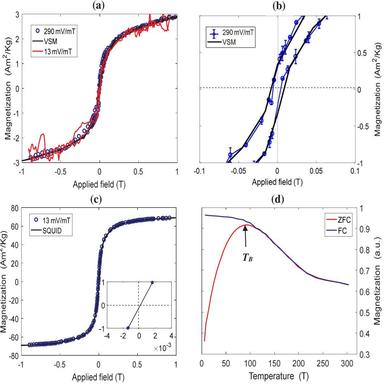
(a) Comparison of magnetization curves of the CoFe2O4 nanoparticles measured with our magnetometer in the 290 mV/mT (circles) configuration, measured with the VSM magnetometer (solid curve in black color) and measured with our magnetometer in the 13 mV/mT (solid curve in red color) configuration. (b) Zerofield region with repeatability error bars in the 290 mV/mT configuration (solid curve in blue color) from the measurements and those measured by the VSM magnetometer (solid curve in black color). (c) Compa